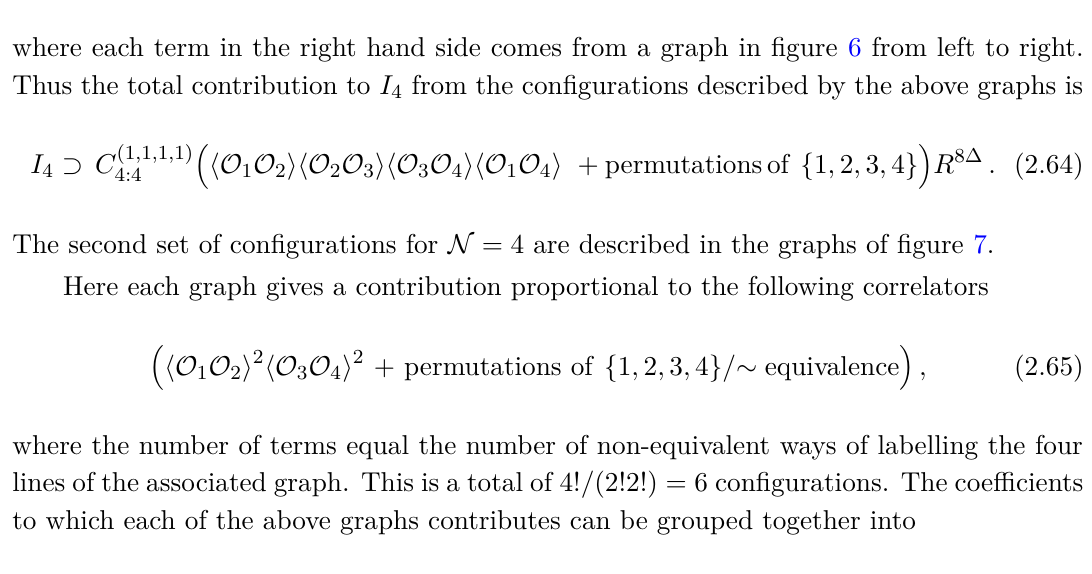
Figure 7 . Graph representation of another class of contributions of the correlator of four twist operators to I 4 when the twist operators have non-trivial support on four